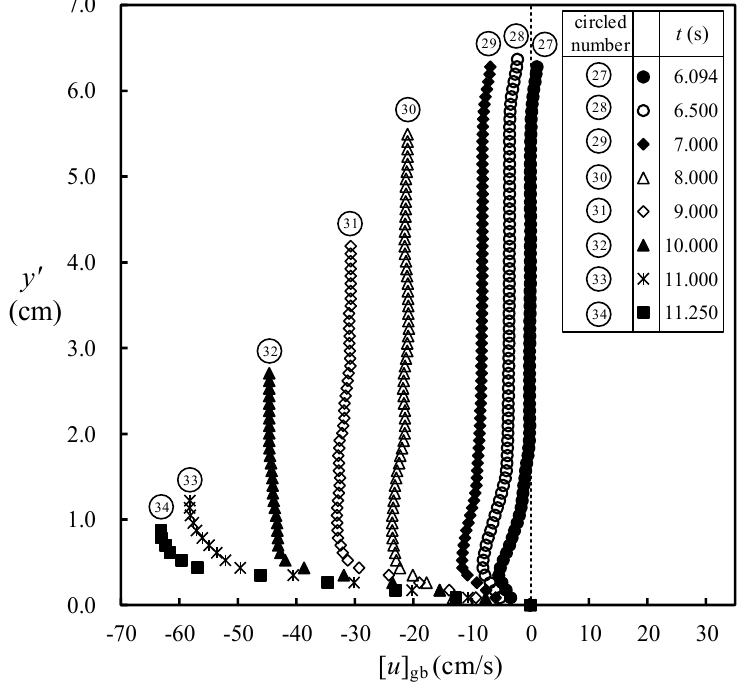
Figure 12. Temporal variation of horizontal velocity profile of pure bore obtained at SMS for 6.094 s ≤ t ≤ 11.250 s during run-down motion (as labeled from circled 27 to 34 in Figure 7a,b).